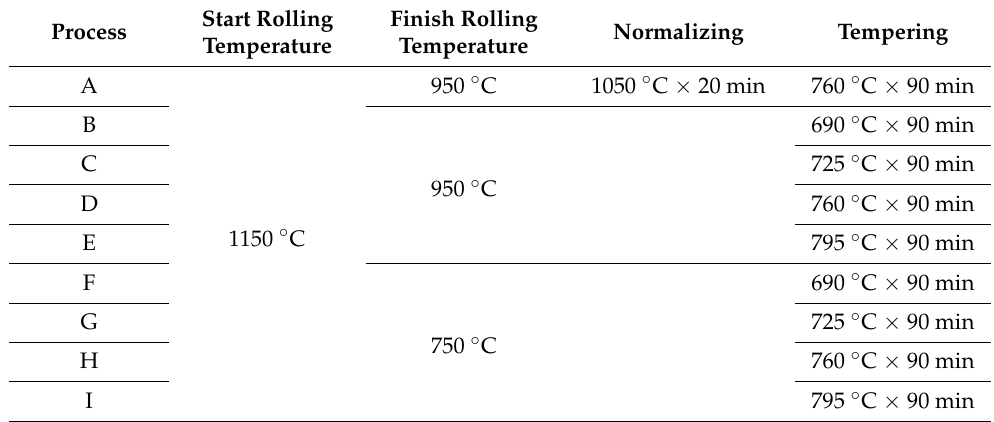
Table 2. Rolling temperatures and heat treatment conditions and the designations. Start Rolling Finish Rolling Process Temperature